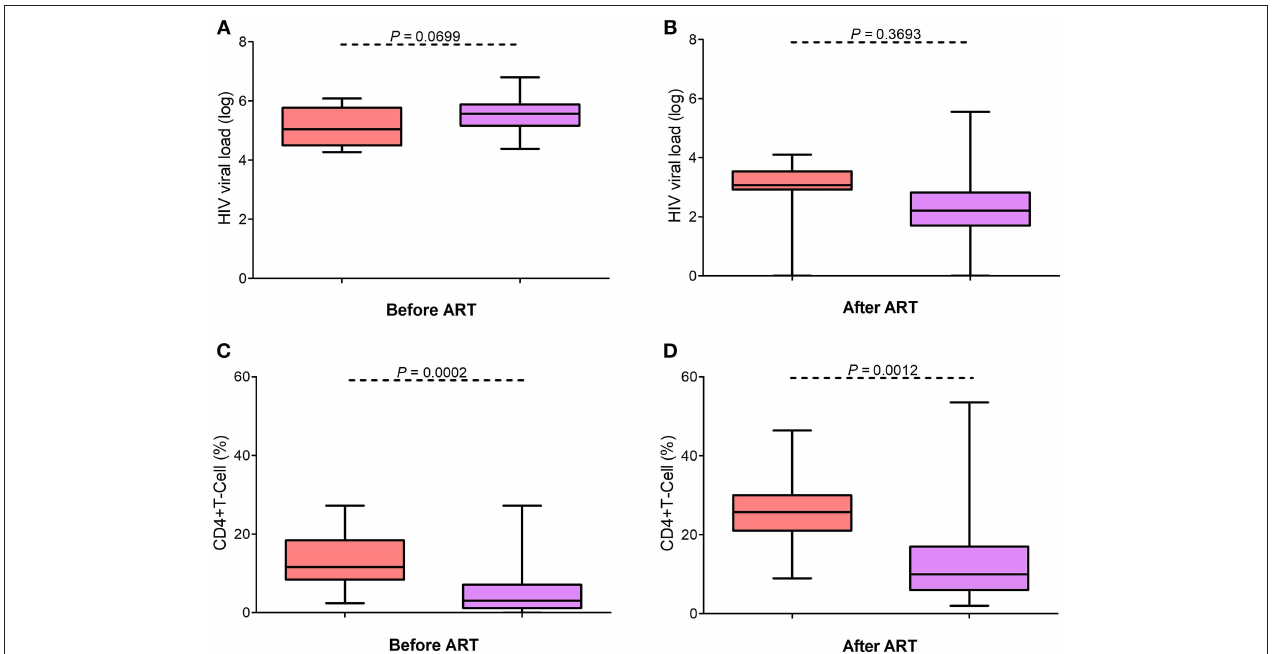
FIGURE 2 | Cross-referencing virologic and immunology profiles in IRIS patients with published reports. No statistical difference was observed between the viral loads in our cohort (pink) and the cases reported in the literature compilation (represented in lilac) at baseline (A) and after ART (B) . Females presenting with IRIS infectious events in the literature compilation presented lower CD4 + T-cell percentages before (C) and after ART (D) than the females with IRIS in our